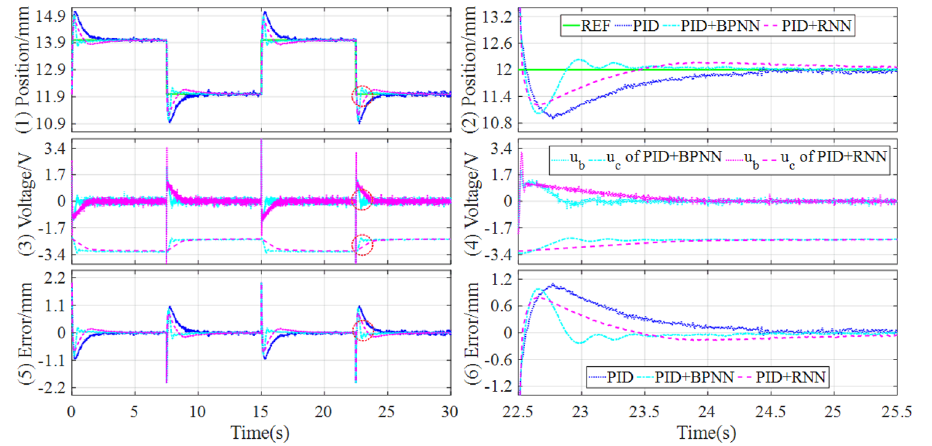
Figure 12. Experimental results of tracking square signal under the different controllers.